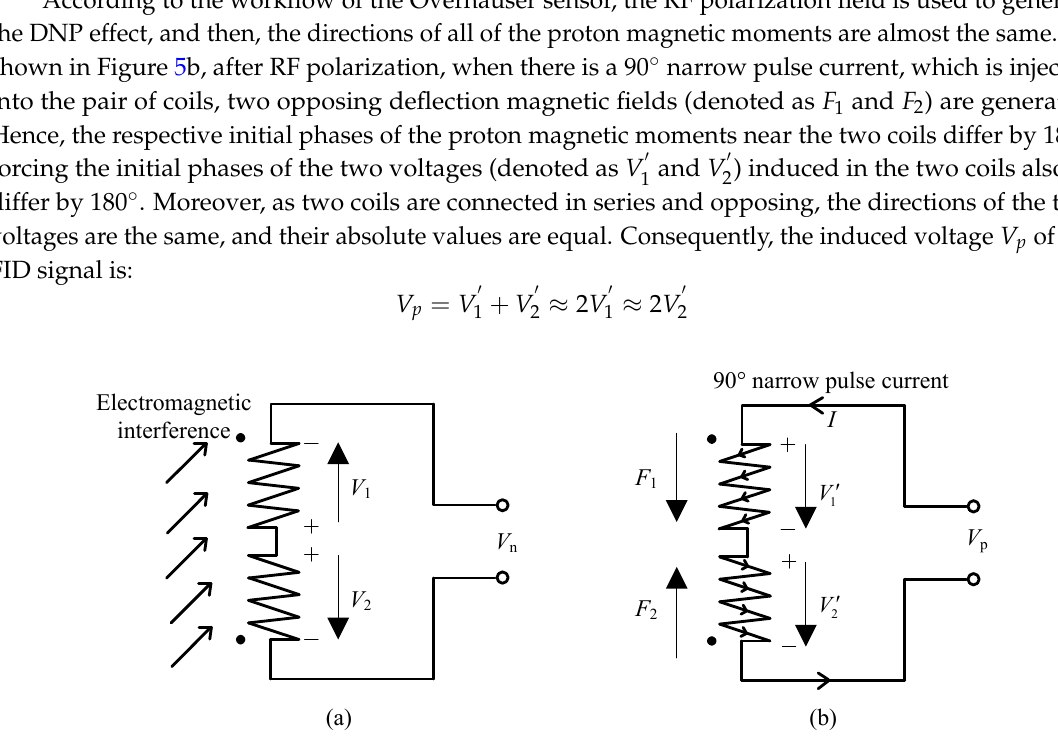
Figure 5. Anti-interference method of the differential dual-coil structure: ( a ) interferences cancel each other; ( b ) receiving Larmor